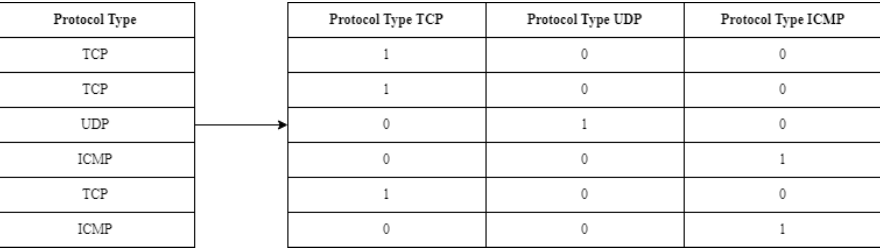
Figure 2. One-Hot Encoding